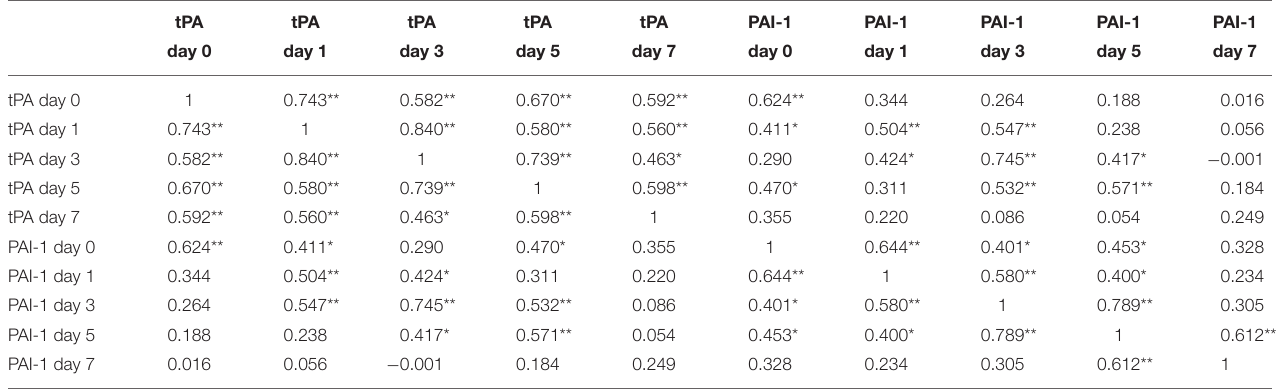
PAI-1, plasminogen activator inhibitor-1; tPA, tissue plasminogen activator. ** The correlation is significant at the 0.01 level (two tailed). * The correlation is significant at the 0.05 level